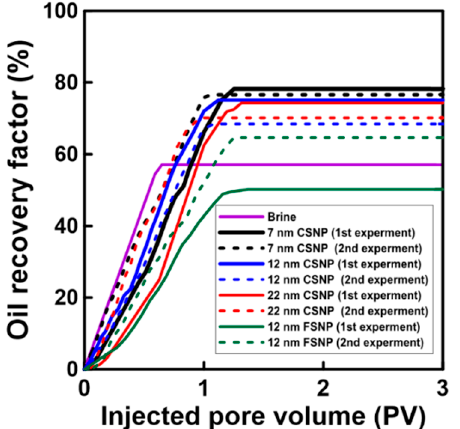
11 of 13 Figure 8. Apparent viscosities of ( a ) NPs and ( b ) NP-stabilized emulsions as a function of shear rate. 3.6. Effect of NP Number Density on the Oil–Water IFT Core flooding of Berea sandstone was conducted using brine and silica NP disper- sions of different diameters (7 nm CSNP, 12 nm CSNP and FSNP, and 22 nm CSNP). All NPs used were identically surface-modified with PSS- co -MA and a zwitterionic surfac- tant. Oil recovery after the injection of silica NPs was greater than the recovery afforded by brine flooding. Oil recovery increased with decreasing particle size; the recovery factor was 78.2% for the 7 nm CSNP dispersion, 75.1% for the 12 nm CSNP dispersion, and 74.2% for the 22 nm CSNP dispersion (Figure 9). These findings may reflect the increase in total NP surface area with decreasing particle size at a fixed particle concentration, such that the NP area in contact with surfactant increases. NP size affected the IFT reduction and the contact angle (Figures 6 and 7). Injection of a 12 nm FSNP dispersion afforded poorer recovery, compared with the CSNP dispersions, thereby reflecting FSNP aggregation that compromised oil recovery. The results of the two FSNP injection experiments showed a sig- nificant difference in the recovery factor, although it was performed under the same conditions; the recovery factor of the first experiment is much lower than the second experiment. This may be because of the difference in oil trapping caused by the occurrence of FSNP aggregation.